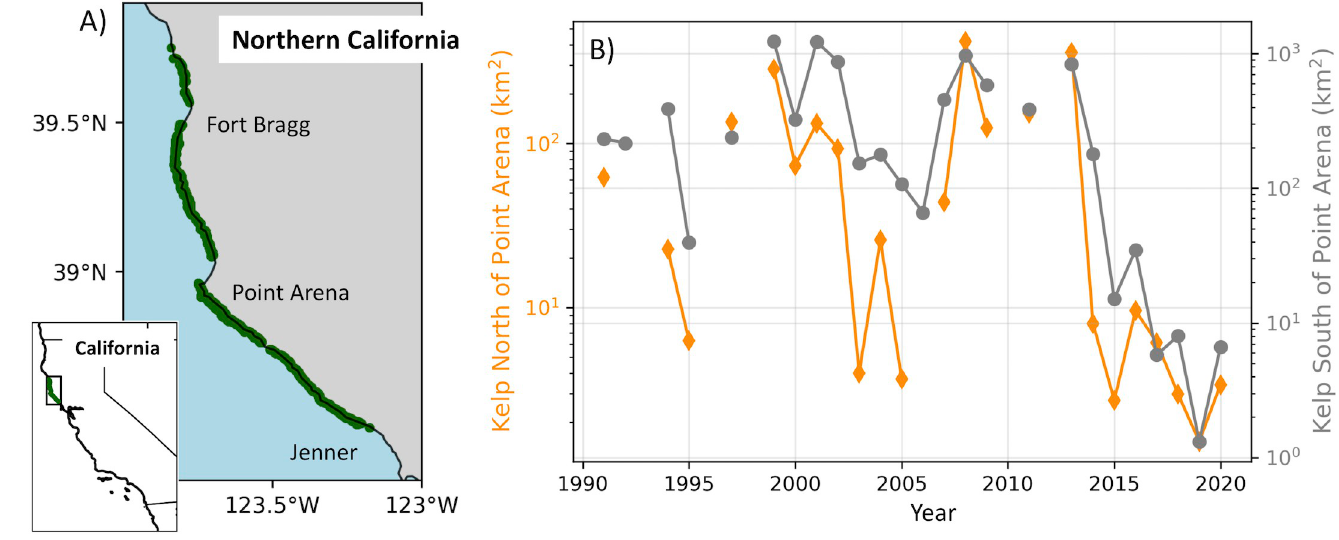
Fig 1. Bull Kelp geographical location and canopy extent. (A) Study region from 38–40˚N on the northern California Coast, U.S.A. Green dots indicate kelp canopy data locations. Extensive sandy beaches are located north of Point Arena and Fort Bragg; no measurable kelp canopy occurs there. (B) Summer kelp canopy extent data (km 2 ), 1991–2020, aggregated regionally for north (orange) and south (gray) of 39˚N (Point Arena). Data derived from [34], freely available under CC BY 4.0 License at https://doi.org/10.6073/pasta/89b63c4b49b80fb839613e9d389d9902.